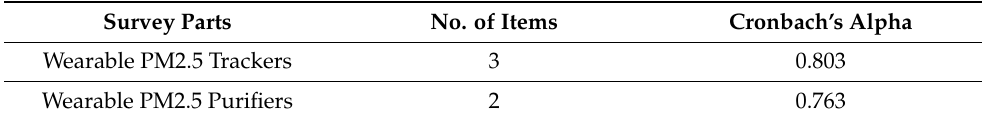
Table 3. Internal consistency of each part of the questionnaire.